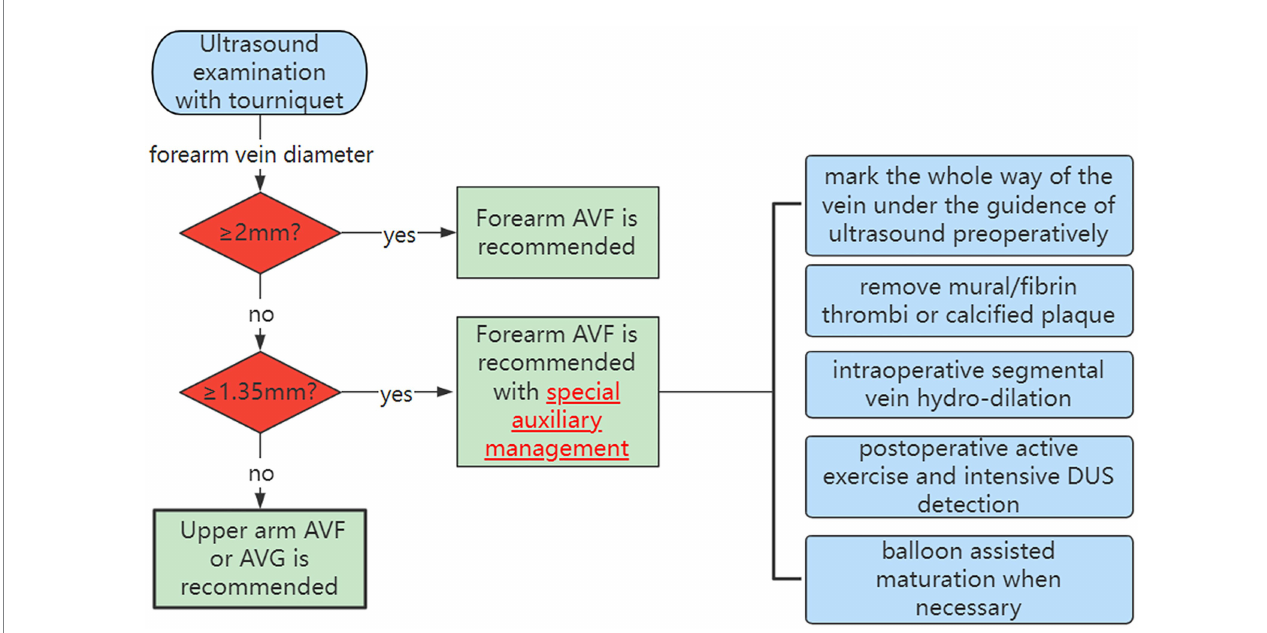
FIGURE 5 The strategies of access placement and maintenance for small-caliber